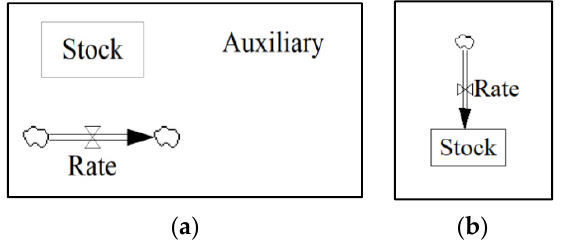
Figure 5. ( a ) Basic building blocks of System Dynamic modelling; and ( b ) rate flowing into a stock.